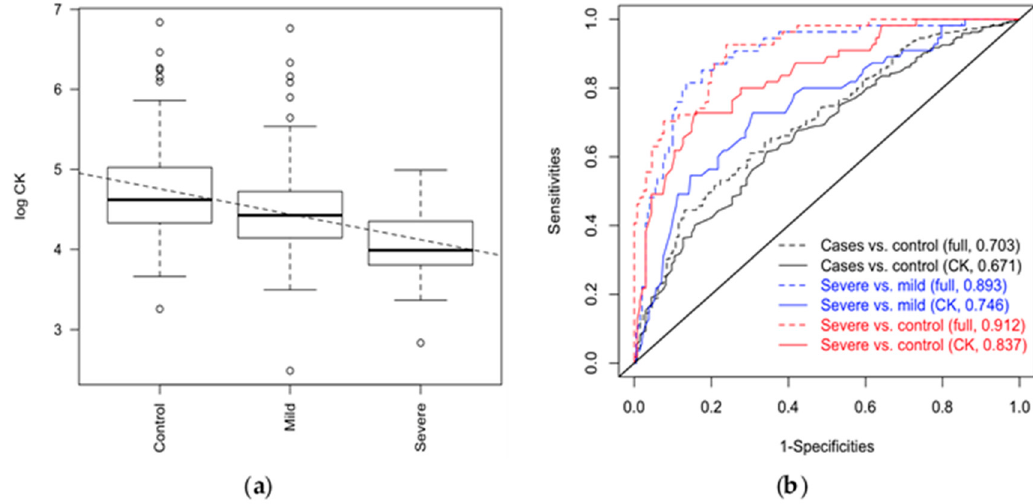
Figure 1. ( a ) Levels of CK and disease outcome. CK was measured in healthy controls n = 136, mild / moderate ME / CFS cases n = 216, and severe ME / CFS cases n = 56. Intercept 5.07411 (se 0.07907, p < 0.001); slope-0.31797 (se 0.04120, p = 0.001). ( b ) ROC curves showing the predictability of a “full” model (including urea, creatinine, bilirubin, albumin, CK, T4; dashed lined) vs CK alone (solid line); areas under the curve (AUC) are presented in the legend. CK = creatine kinase; ME / CFS = Myalgic Encephalomyelitis / Chronic Fatigue Syndrome; ROC = Receiver Operating Curves.